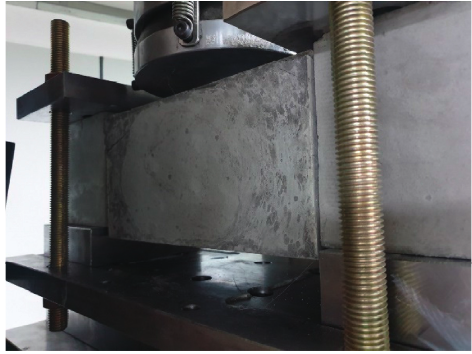
Figure 19: Shear planes of concrete